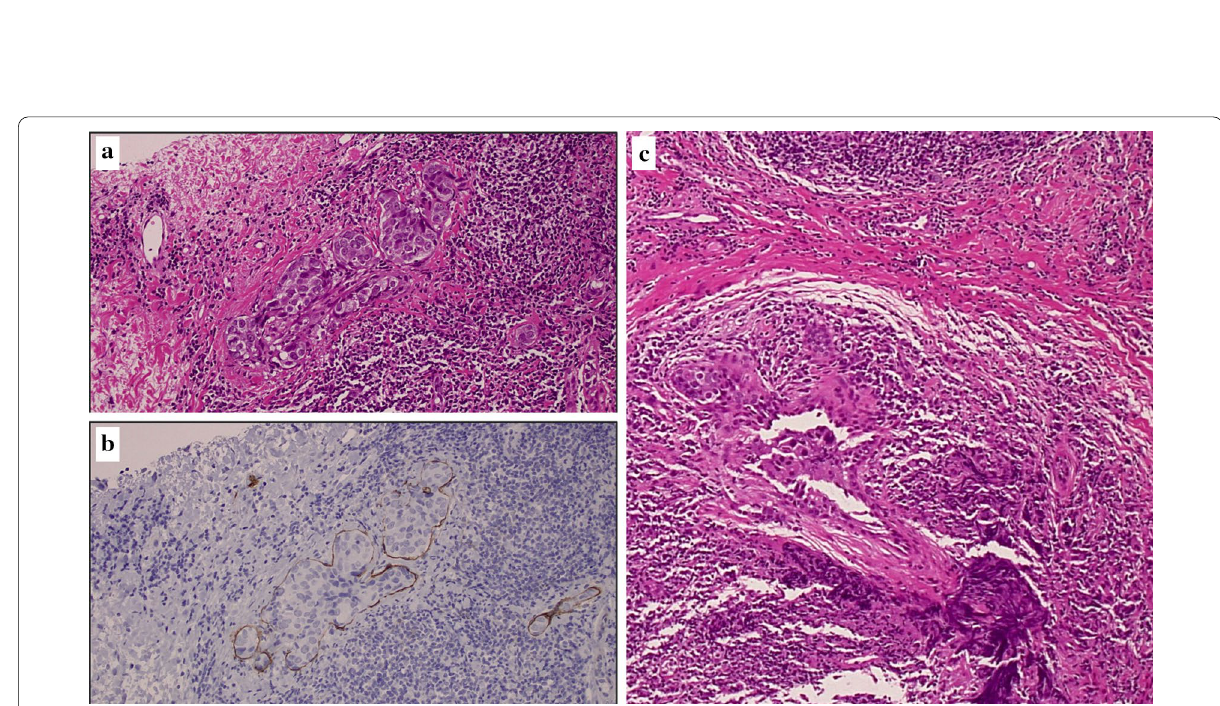
Fig. 4 Histopathological examinations of biopsy before chemotherapy. a Atypical cells with enlarged chromatin nuclei and eosinophilic endoplasmic reticulum form vesicular nests on hematoxylin–eosin stain. b D2-40 staining is positive, indicating that the tumor cells have infiltrated the lymphatic vessels. c Atypical cells with enlarged nuclei and eosinophilic sporangium form a vesicular structure and proliferate. It is a highly atypical invasive ductal carcinoma of the